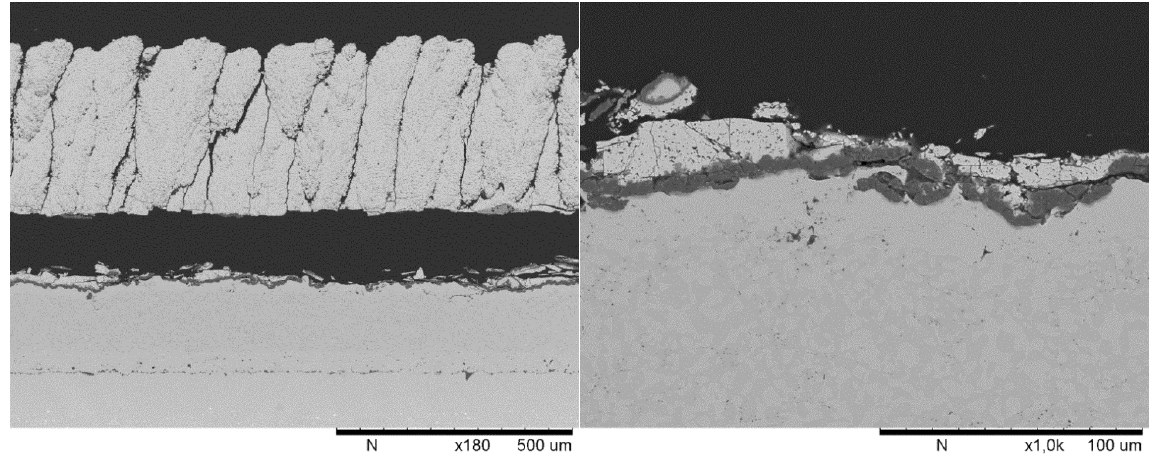
Figure 12. Suspension C1, approximately 160 TCF cycles.